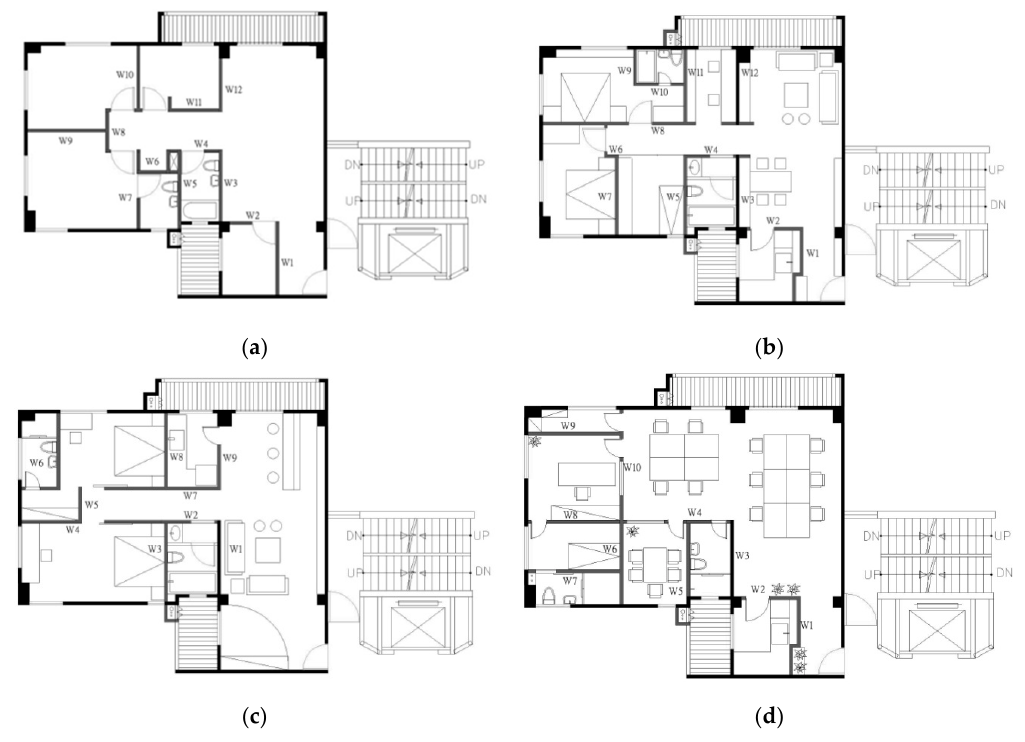
Figure 2. Structure adjustment scenarios. ( a ) Original structure; ( b ) the first variation; ( c ) the second variation; ( d ) the third variation.